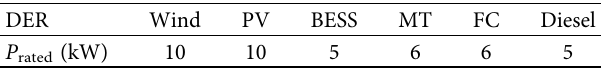
Table 1: Te capacity of distributed energy